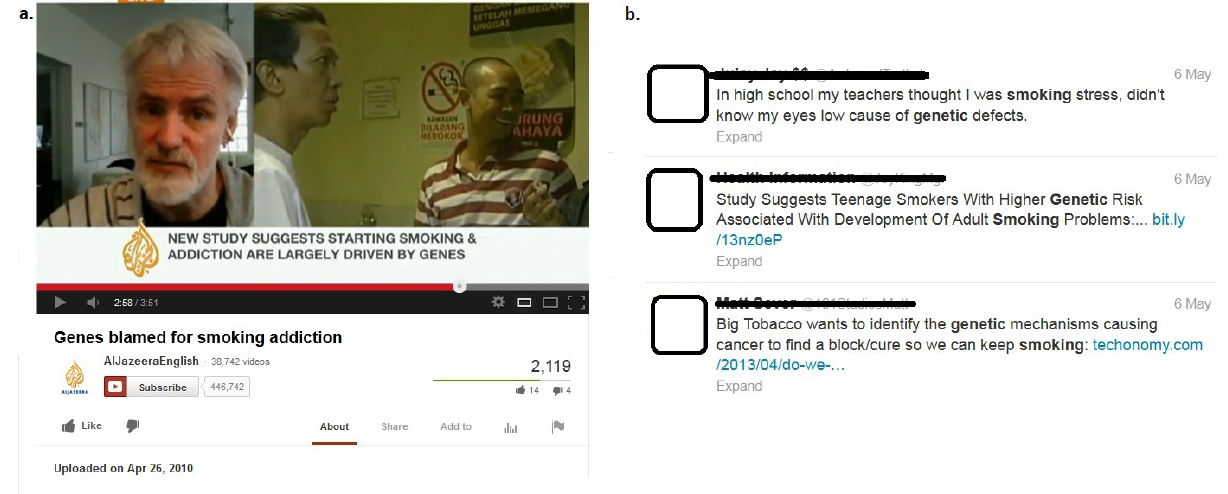
Figure 1. Screenshots of YouTube and Twitter results. (a) screenshot of YouTube; (b) screenshot of